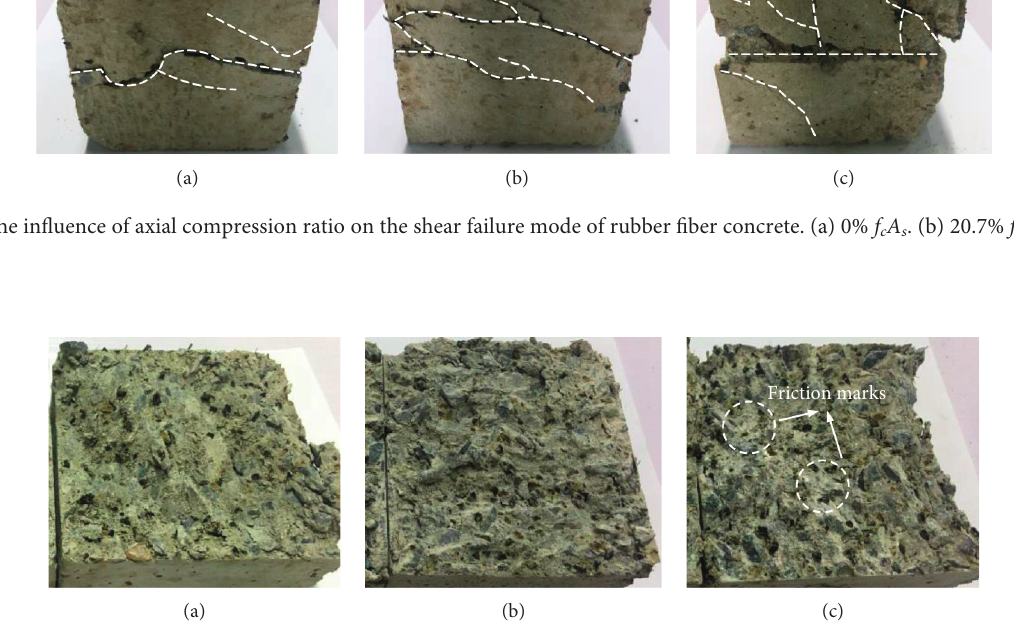
c A s . (b) 20.7% f c A s . (c) 41.4%